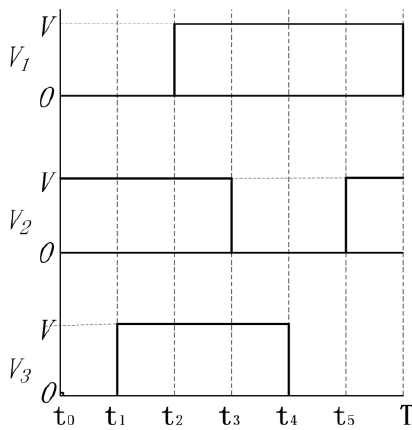
Figure 4. Exciting voltage signals applied to piezoelectric elements.